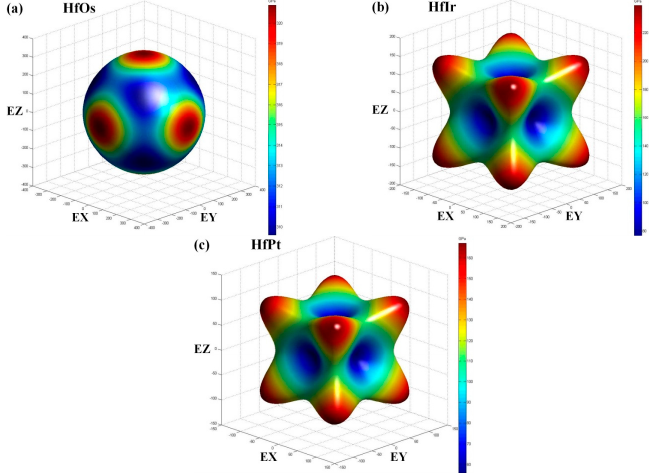
Figure 4. The 3D surface construction of Young’s modulus in ( a ) HfOs, ( b ) HfIr and ( c ) HfPt by GGA method. (Magnitude of Young’s modulus at different directions is presented by the contour along each graph with the unit of